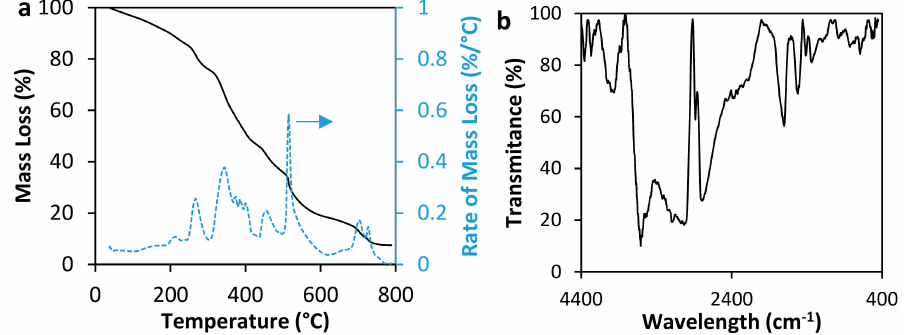
Figure 2. Characterization of acrylamide / sodium acrylate copolymer by ( a ) TGA and ( b ) FTIR